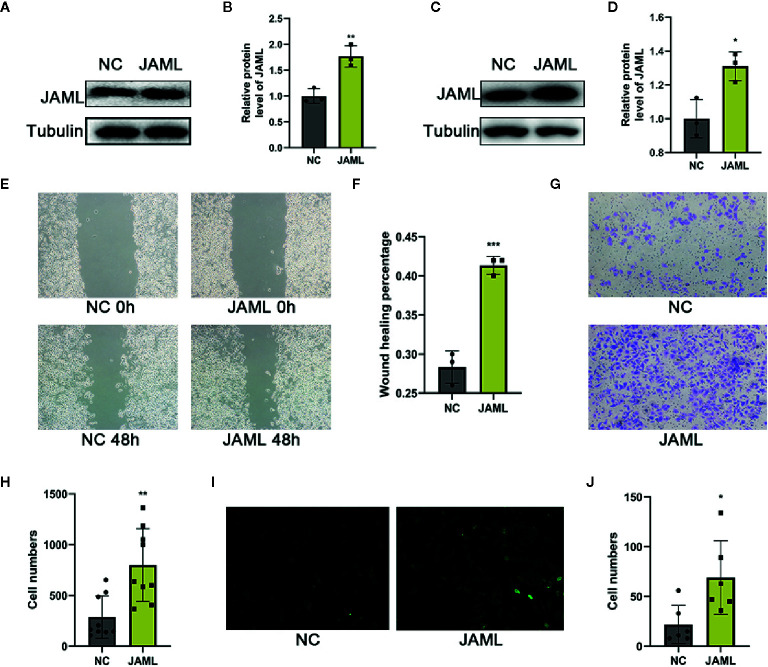

(A) JAML expression in HGC-27 cells after transfection with JAML plasmid for 72h. (B) Quantitative analysis of (A) n=3, unpaired t test, **P < 0.01, compared with NC group. (C) JAML expression in HGC-27 cells after transfection with JAML plasmid for 120h. (D) Quantitative analysis of (C) n=3, unpaired t test, *P < 0.05, compared with NC group. (E) Wound healing assay to assess cell migration in HGC-27 cells. (F) Quantitative analysis of (E) n=3, unpaired t test, ***P < 0.001, compared with NC group. (G) Transwell migration assay to evaluated cell migration in HGC-27 cells. (H) Quantitative analysis of (G) n=9, unpaired t test, **P < 0.01, compared with NC group. (I) EdU incorporation assay to observe cell proliferation in HGC-27 cells. (J) Quantitative analysis of (I) n=6, unpaired t test, *P < 0.05, compared with NC group. NC, negative control.